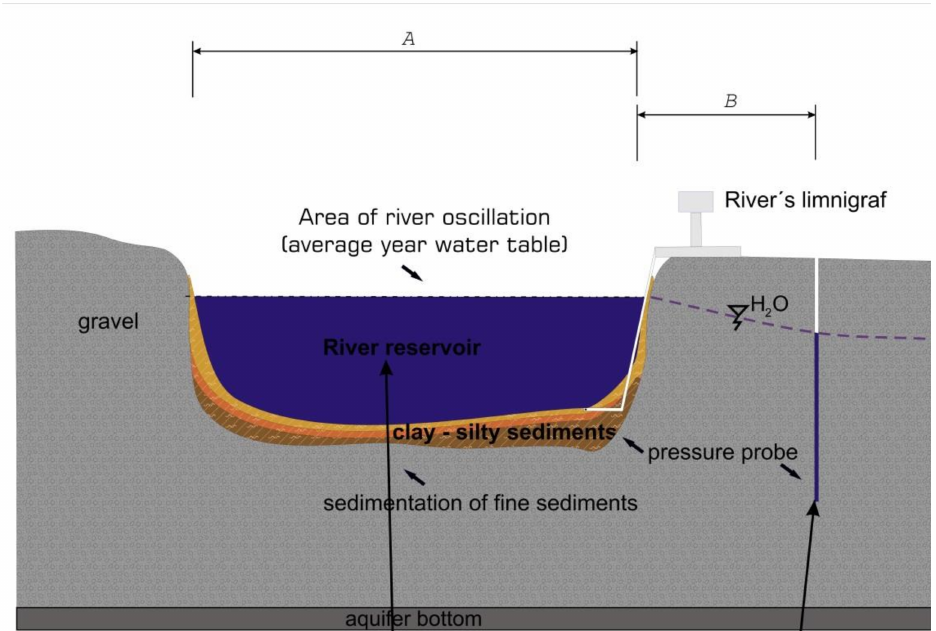
Figure 2. Schematic cross-section of the Sava